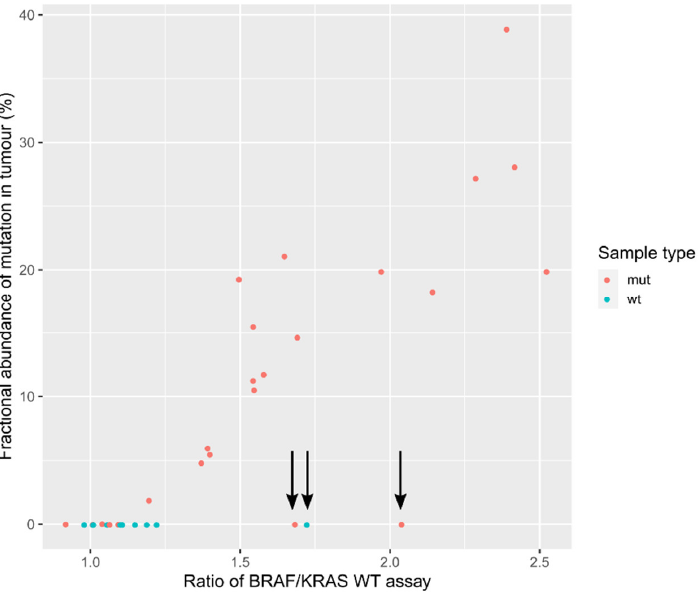
Figure 6. Plot representing the BRAF/KRAS WT assay measurement ratio and its dependence on the fractional abundance of measured mutation in tumor. If the sample is wild type (WT), the expected ratio of BRAF/KRAS WT assay measurement would be around 1. If the tumor sample is mutated (MUT), then a higher percentage of mutation is measured, increasing the BRAF/KRAS ratio. The three samples that do not follow the pattern are marked with arrows.